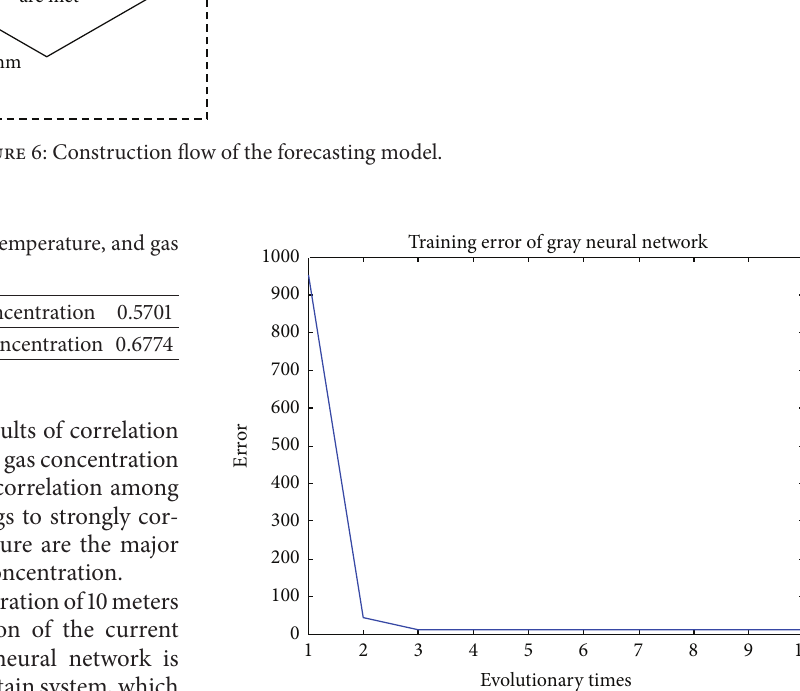
Figure 7: The change in the training error of the gray neural